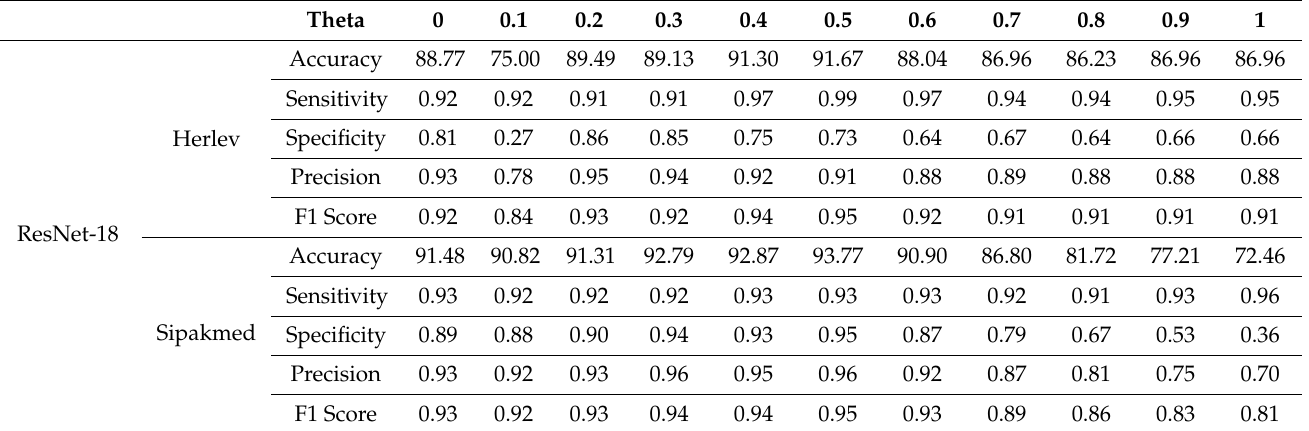
The results of the RestNet-18 model are shown in Table 12. The highest classification accuracy on the Herlev dataset is 91.67% and good sensitivity of 99% with θ 0.5, whereas 92.87% is the highest classification accuracy on the Sipakmed dataset and good sensitivity of 93% with θ 0.4. Performance Evaluation of ResNet-18 Pre-Trained Model with Fuzzy Min–Max Neural